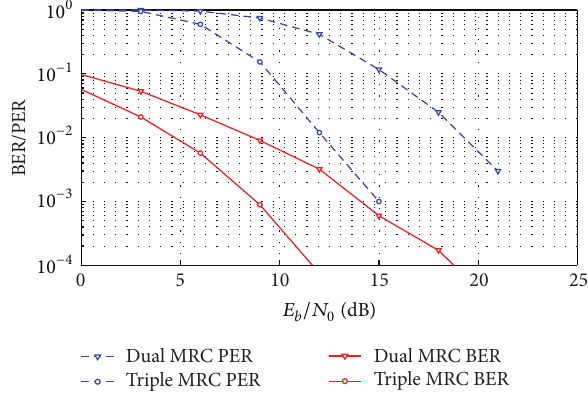
Figure 8: The BER and PER performances using MRC in the PS 3D multipolarized multipath Rician fading channel.